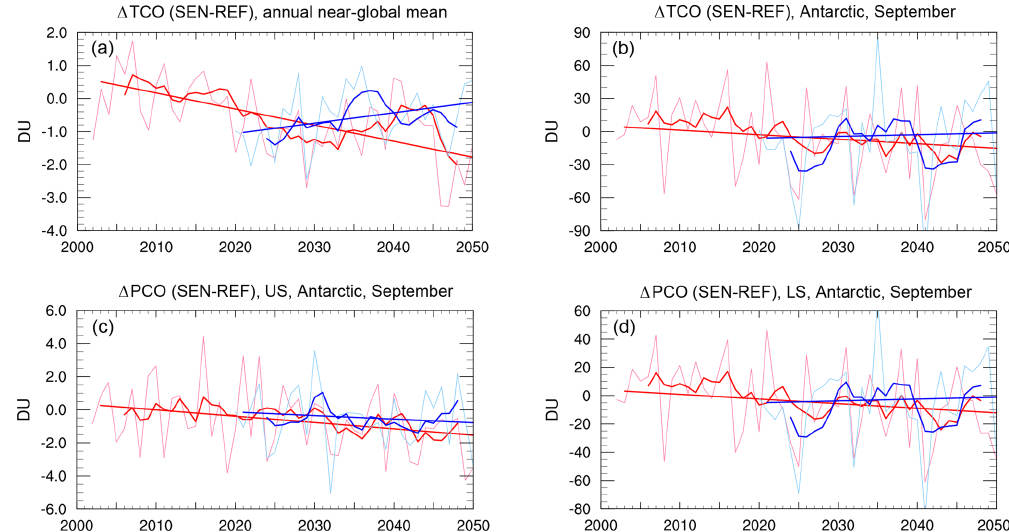
Figure 7. Different temporal evolution of column ozone differences (in DU) between the individual sensitivity simulations and the reference simulation (in DU): SEN-C2-fCFC11_2050 minus REF-C2 values are indicated in red, and SEN-C2-fCFC11_2020 minus REF-C2 values are shown in blue. (a) TCO for the annual near-global mean (60 ◦ S–60 ◦ N); (b) TCO for the Antarctic (70–90 ◦ S) in September; (c) PCO for the Antarctic (70–90 ◦ S) in the US in September; (d) PCO for the Antarctic (70–90 ◦ S) in the LS in September. The red and blue lines show the trend estimates for the unsmoothed time series using a multiple linear regression – including differences in temperature anomalies as the dependent variable – which accounts for possible autocorrelation with lag 1 (see text for